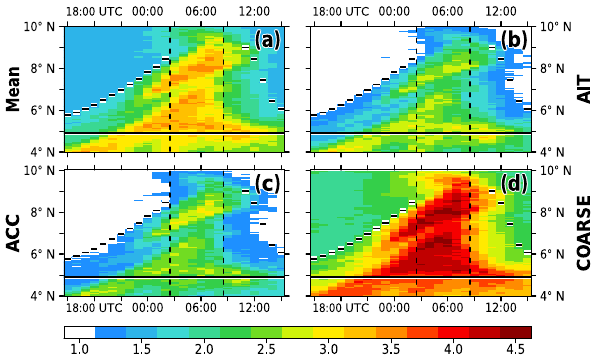
Figure 5. Same as Fig. 3 but for the GF ( d p,wet d − 1 to (a) mean GF, (b) GF AIT , (c) GF ACC and (d) GF COARSE .